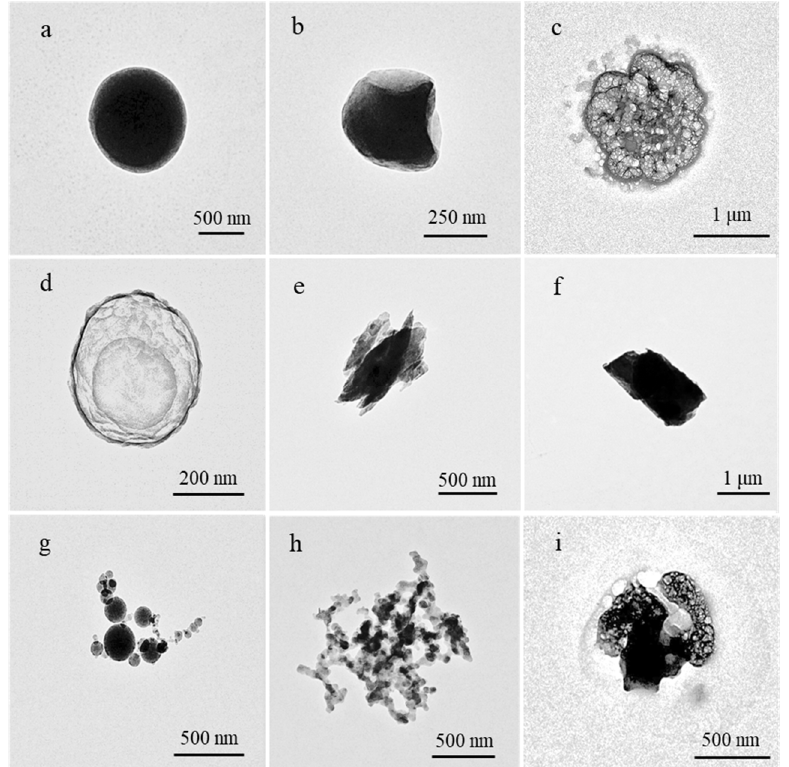
Figure 1. TEM images of individual particles in the winter haze of Xi’an during the sampling period. ( a ) Spherical organic particle. ( b ) Irregularly shaped organic particle. ( c ) Non ‐ volatile sulfate. ( d ) Foamed sulfate. ( e ) Mineral: Si + Al. ( f ) Mineral: Ca. ( g ) Fly ash particles. ( h ) Soot particles. ( i ) K ‐ rich particle.